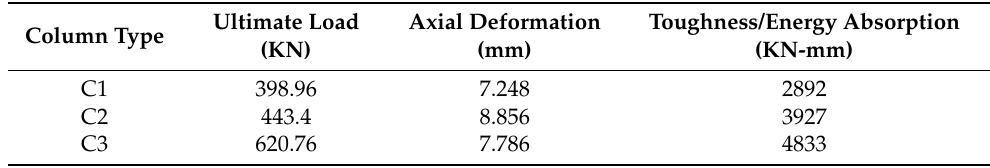
Table 7. Axial behavior of confined concrete.